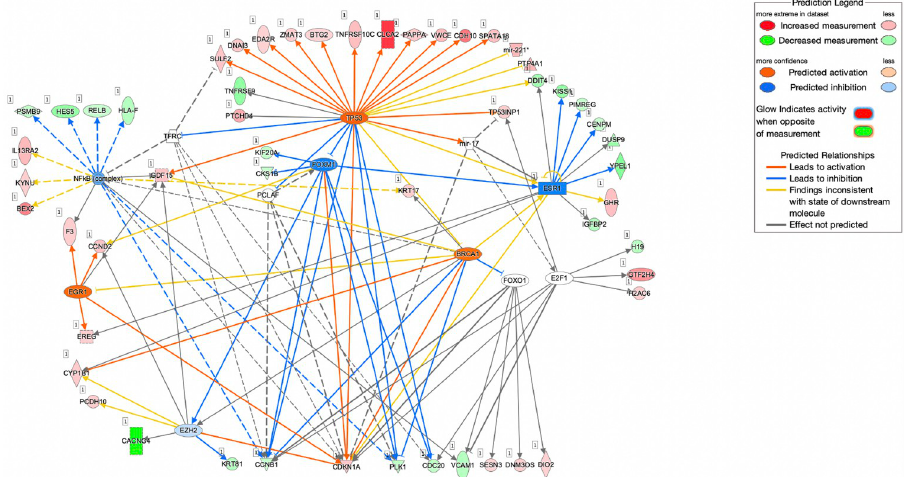
Fig 9. A mechanistic network showing the relationship between TP53 and several other sets of connected upstream regulators could elicit the expression of the DEGs observed in MOL-treated hWJMSCs. Nodes represent gene products and red coloured nodes indicate up-regulated genes and green coloured nodes indicate down-regulated genes; Edges represent direct (solid line) and indirect (dashed line) interactions between molecules based on information present within the Ingenuity knowledge base; Node shapes are related to functional classes where vertical rectangles are for G-protein coupled receptors, horizontal rectangles for ligand-dependent nuclear receptor, squares for cytokines, triangles for phosphatases, inverted triangles for kinases, vertical diamonds for enzymes, horizontal diamonds for peptidase, vertical ellipses for transmembrane receptors, horizontal ellipses for transmembrane regulators and circles for